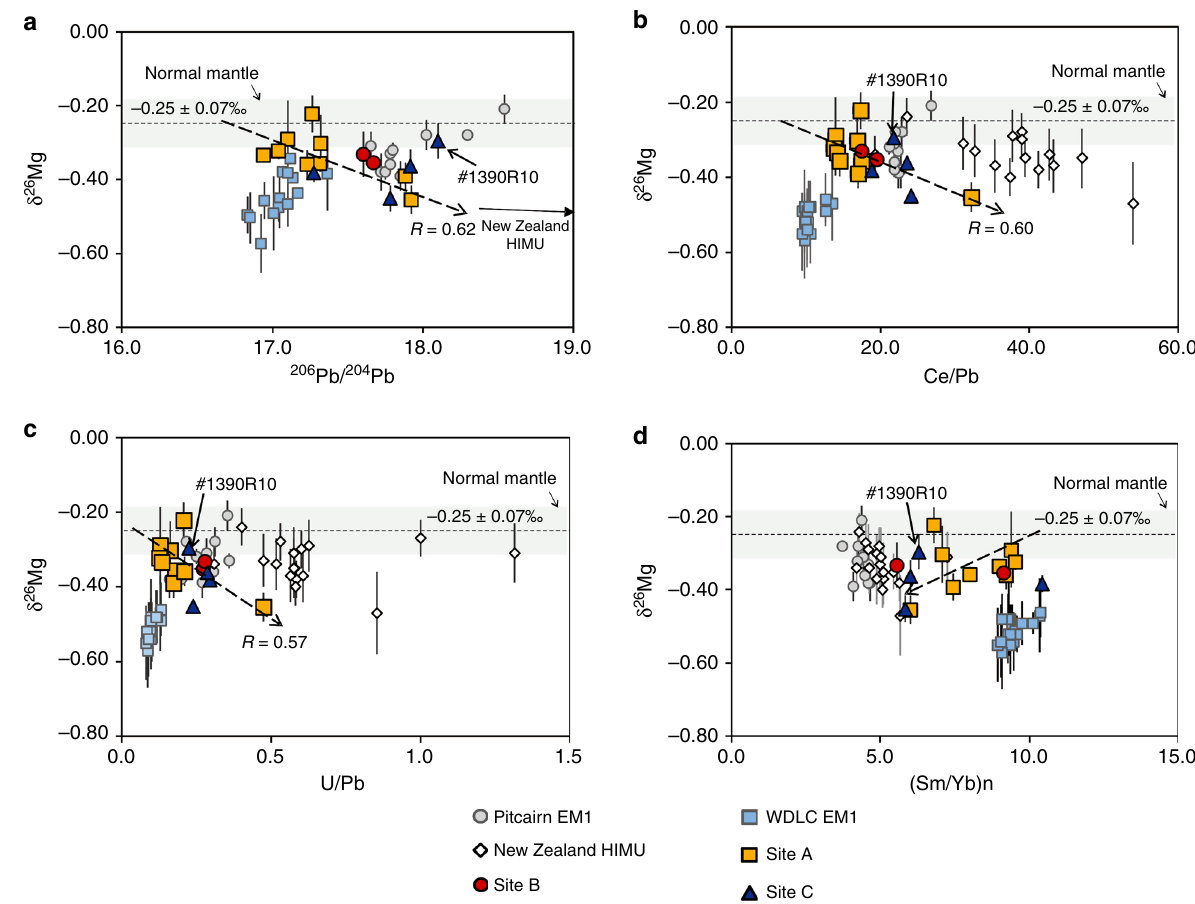
Fig. 4 δ 26 Mg vs. elemental and radiogenic isotopic ratios for petit-spot basalts. a the comparison of δ 26 Mg with 206 Pb/ 204 Pb ratio. The symbols have been explained below the fi gure, and they are the same as in Fig. 3. The dark arrow points to the New Zealand HIMU samples are from the South Island and Antipodes Islands, for which the ancient recycled eclogites have been suggested to explain the origin low δ 26 Mg isotope values coupled with high Pb isotope ratios 42 . The sample from Site C, labeled as #1390R10, is marked because it plots outside the TiO 2 - δ 26 Mg linear trend shown in Fig. 3b. The dashed line with an arrow indicates the linear regression line (regression coef fi cients shown) fi tting with all petit-spot lavas except #1390R10. b the comparison of δ 26 Mg with Ce/Pb ratio. The white diamonds are the New Zealand HIMU samples. Others are the same from a . c the comparison of δ 26 Mg with U/Pb ratio. d the comparison of δ 26 Mg with primitive mantle normalized Sm/Yb